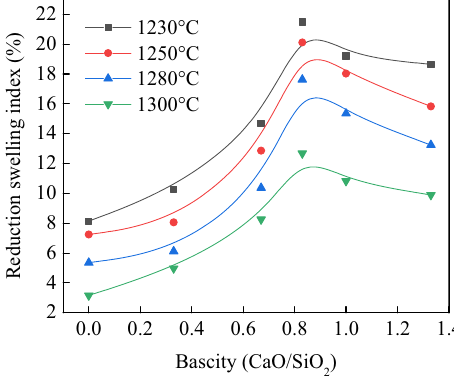
Figure 11: In fl uence of basicity on the RSI of the